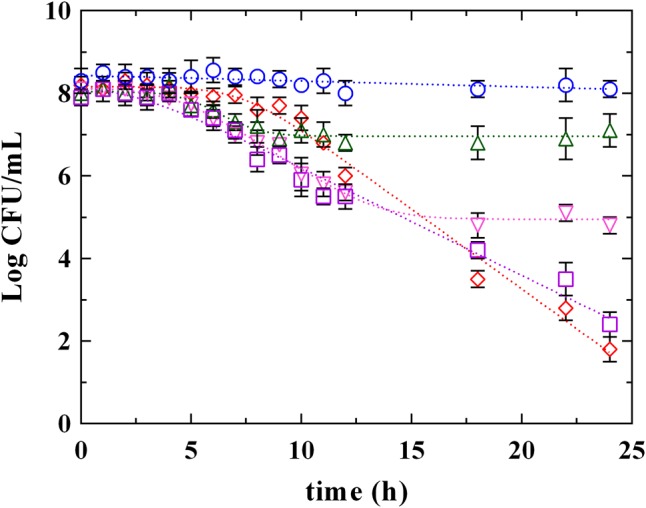
Survival of L. innocua ATCC 33090 in (∘) MSE buffer (C), or in MSE buffer containing: (□), gallic acid (GA_MIC); (△), ferulic acid (FA_MIC); (▽), caffeic acid (CA_MIC) or (♢), phenyllactic acid (PLA_MIC) at MIC concentration detected at pH 5.5. Symbols represent the mean values with standard deviation of three independent experiments and the curves represent the survival models obtained with GInaFiT software.